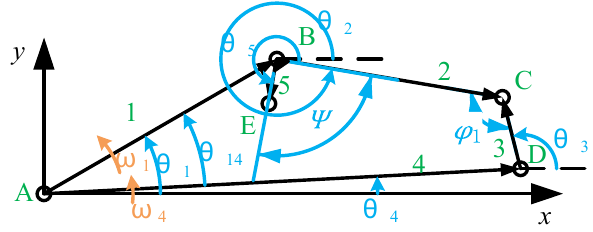
Figure 11 . Principle illustration of the cam five-bar mechanism.